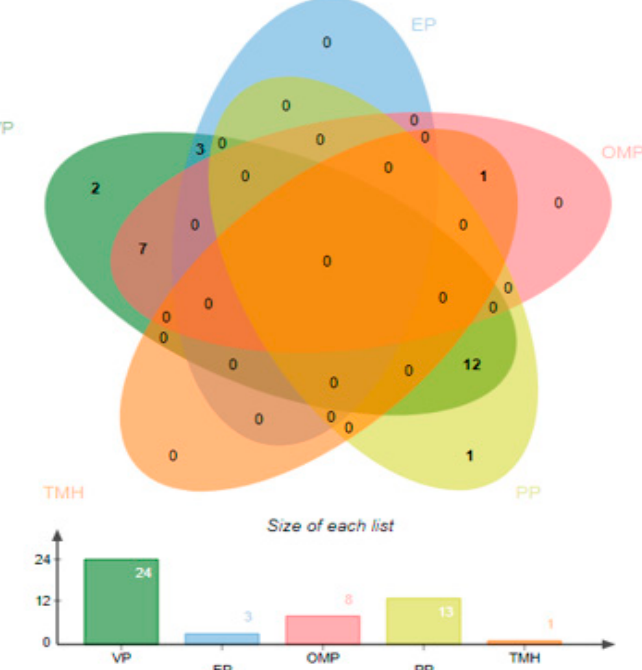
Figure 2. The number of surface localized proteins obtained is represented as Venn. Number of virulent proteins (VP), periplasmic proteins (PP), outer membrane proteins (OMP), extracellular proteins (EP), and transmembrane helices (TMH).